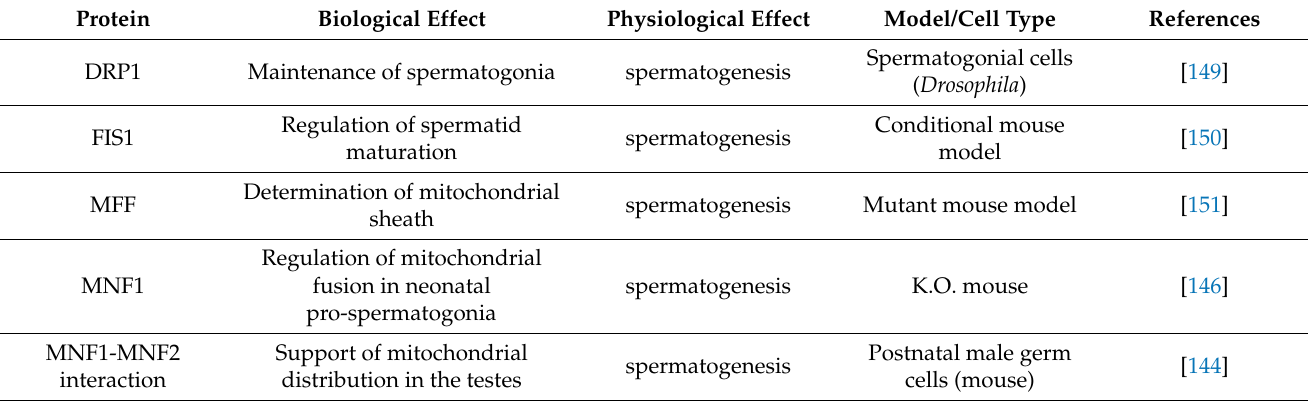
Table 3. Effect of proteins directly or indirectly involved in the regulation of mitochondrial dynamics on spermatogenesis or